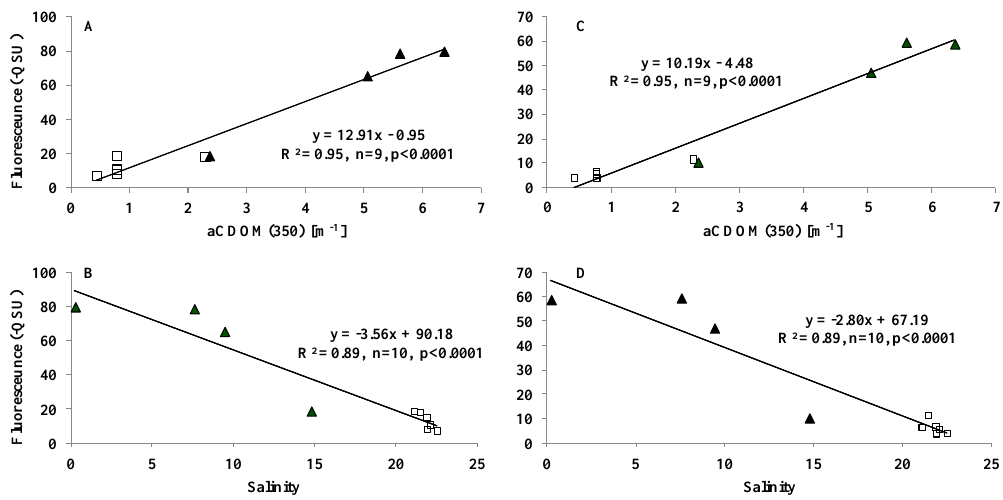
Fig. 9. Relationships observed between C1 (A) , (B) and C2 (C) , (D) components with absorption coefficient of CDOM at 350nm ( a CDOM (350)) and salinity determined in the Mackenzie Delta (triangles) and North West sectors